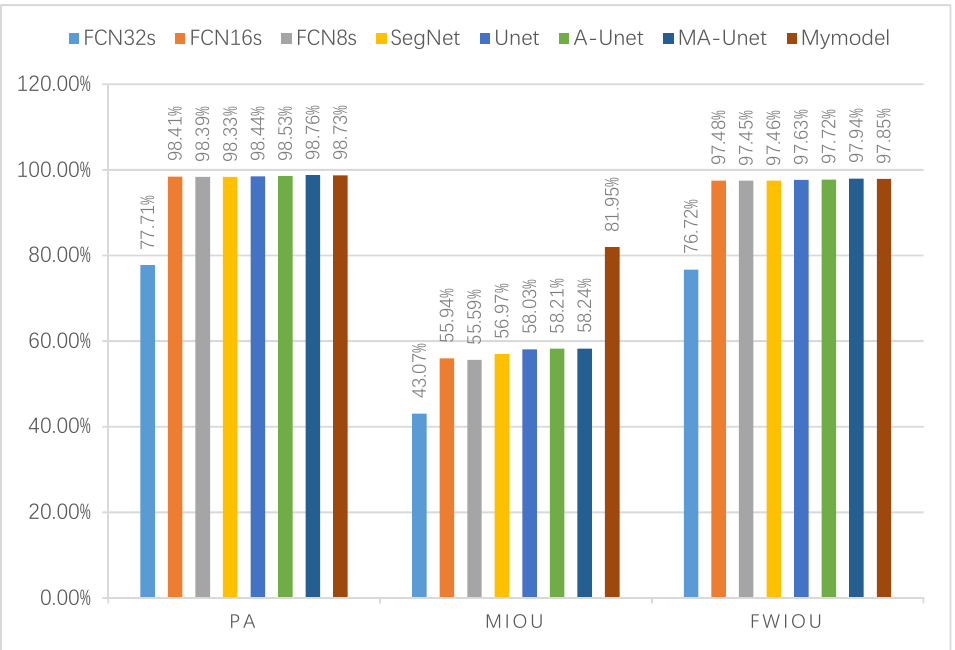
Figure 5. Comparison experiment results of power line extraction.